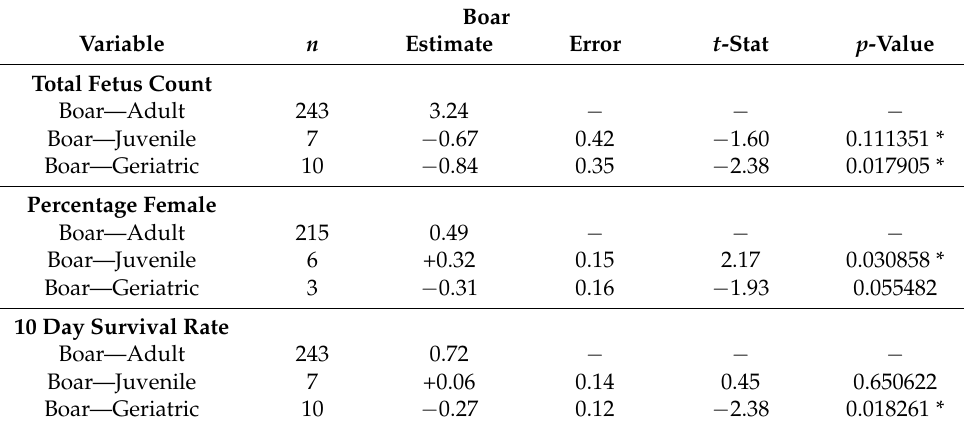
Table 4. Analysis of the effects of strain 13/N guinea pig boar age at delivery on breeding outcomes. ANOVA was used to analyze differences in mean total fetus count, percentage of female pups in the litter, and pup survival rate after 10 days for juvenile or geriatric guinea pigs as compared to adult guinea pigs. Age is based on the age of the parental boar at pup